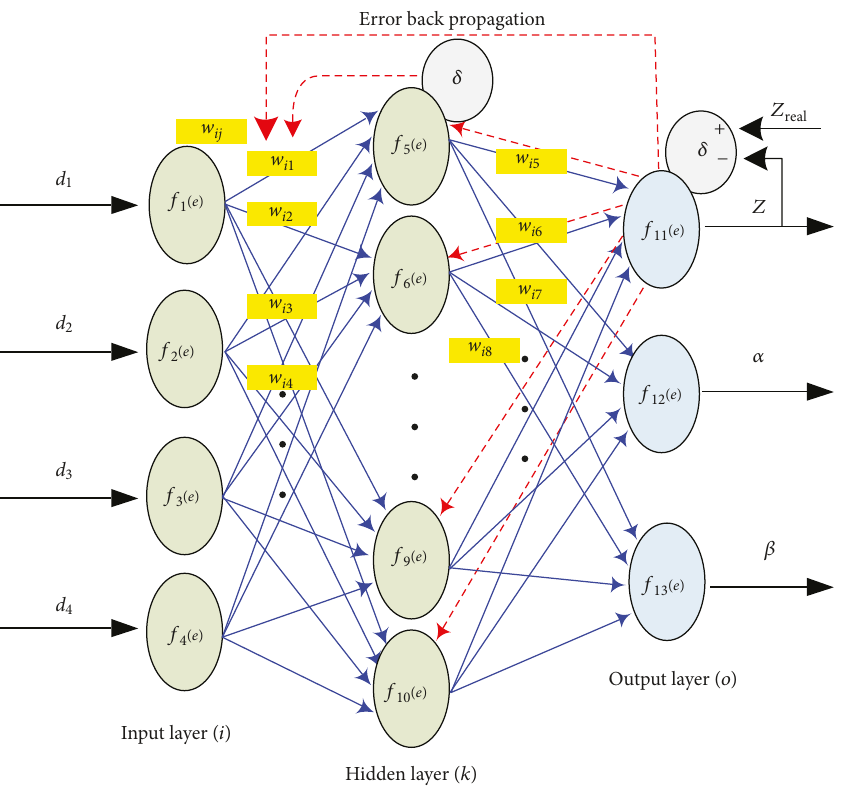
Figure 3: Topological structure of the BP neural network.